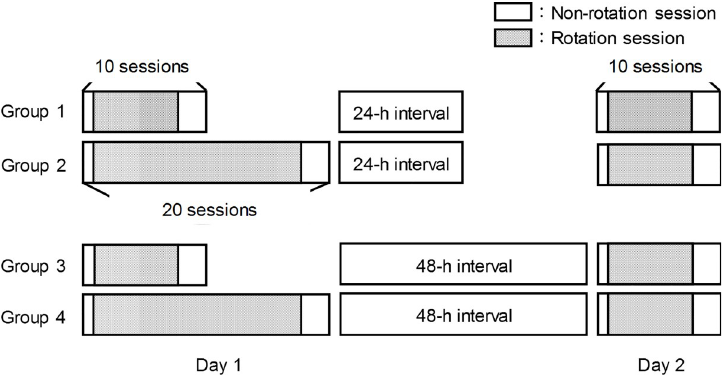
Fig 2. Training schedule. The participants were assigned to one of four groups that differed in terms of the amount of practice on Day 1 and the time interval between Day 1 and Day 2. The gray parts of the bars represent rotation sessions, and the white ones represent non-rotation sessions. Groups 1 and 2 performed the task twice with a 24-h interval, while Groups 3 and 4 performed it twice with a 48-h interval. Groups 1 and 3 performed 10 sessions on Day 1, whereas Groups 2 and 4 performed 20 sessions on Day